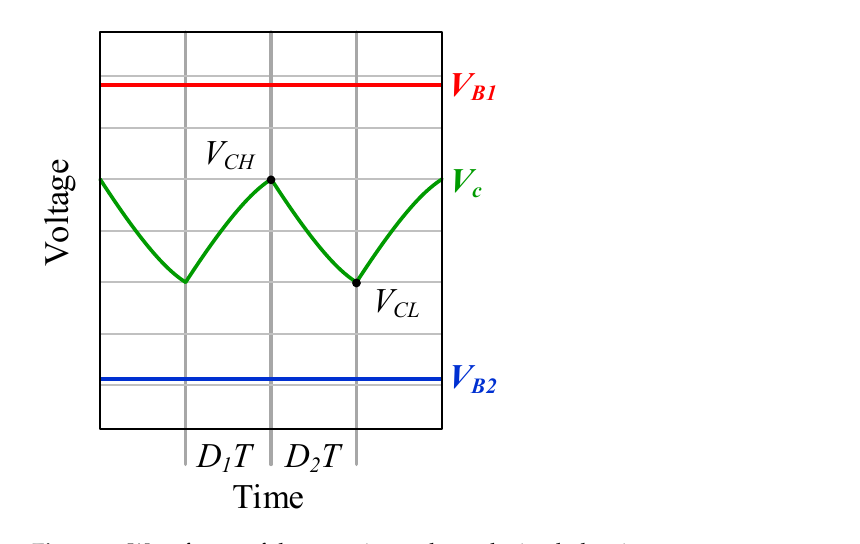
Figure 9. Waveforms of the capacitor voltage during balancing processes.